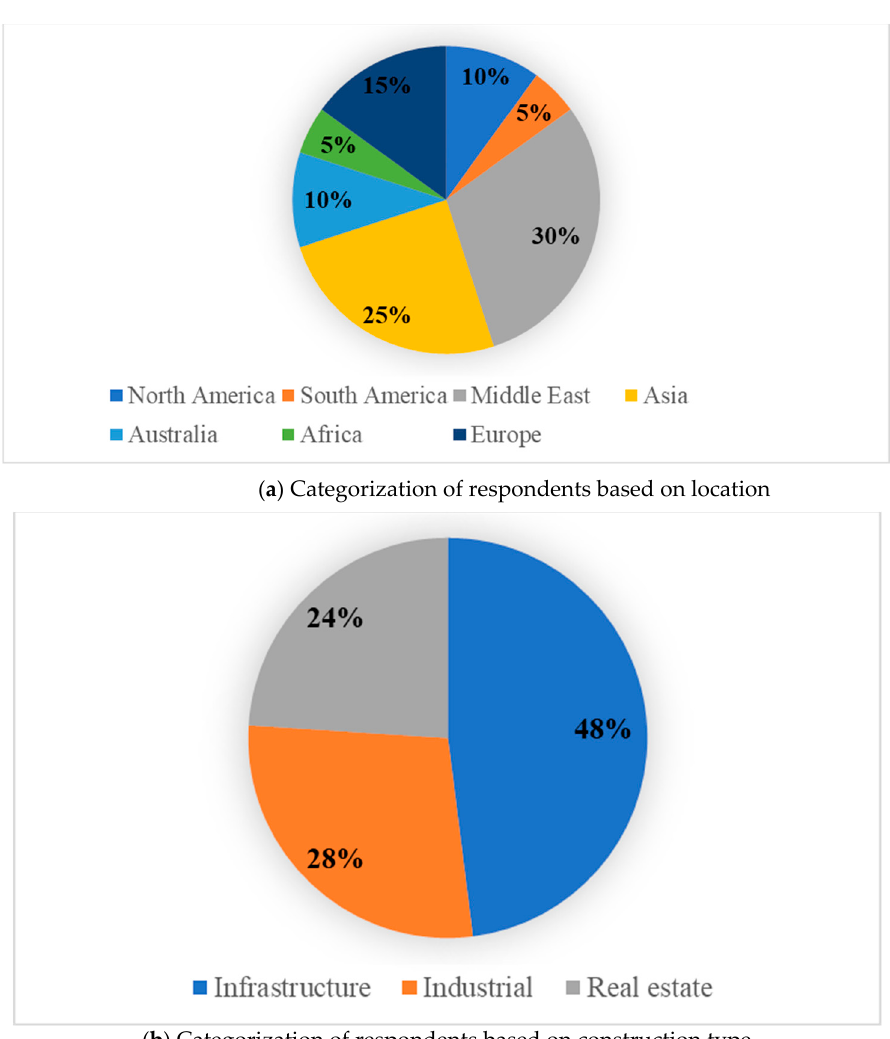
Figure 4. Categorization of respondents based on location and construction type.